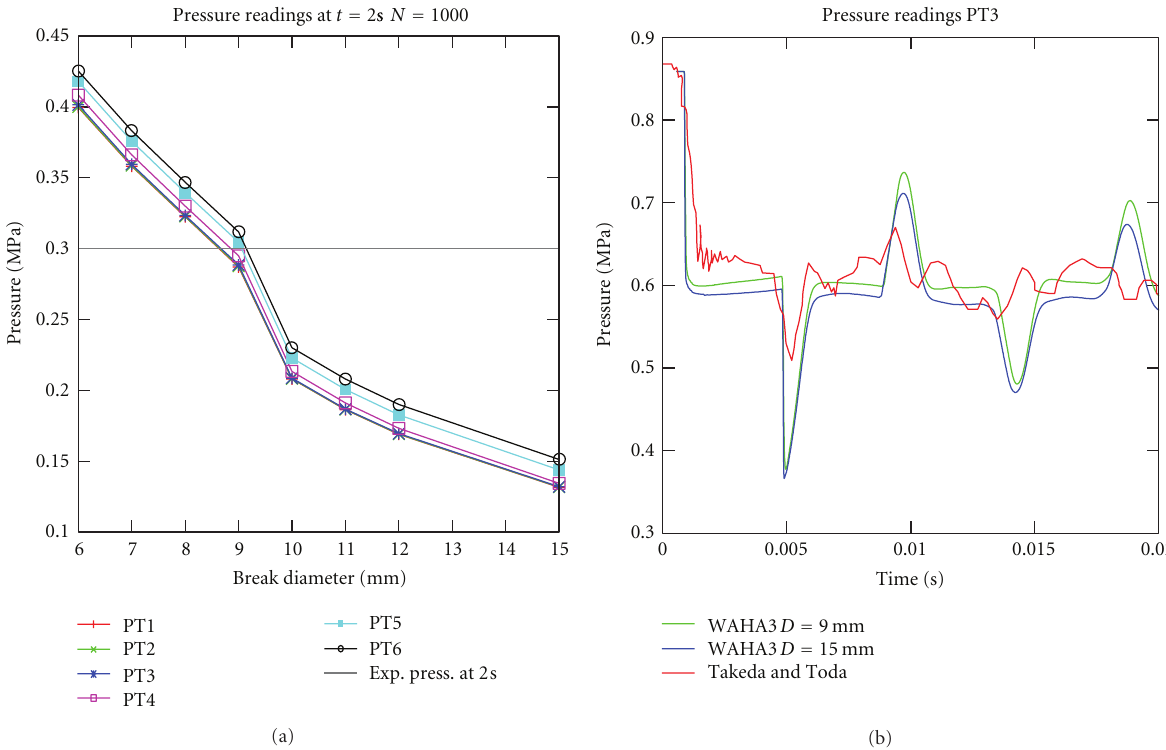
Figure 8: (a) Final simulated pressure at PT locations using di ff erent break diameters. (b) PT3 pressure readings using 9 and 15 mm break diameters.